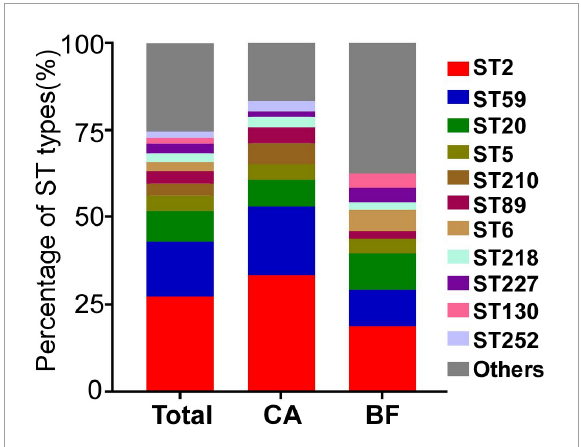
FIGURE1 The MLST types of Staphylococcus epidermidis strains isolated from different infection sites. CA, isolates from catheters; BF, isolates from sterile body